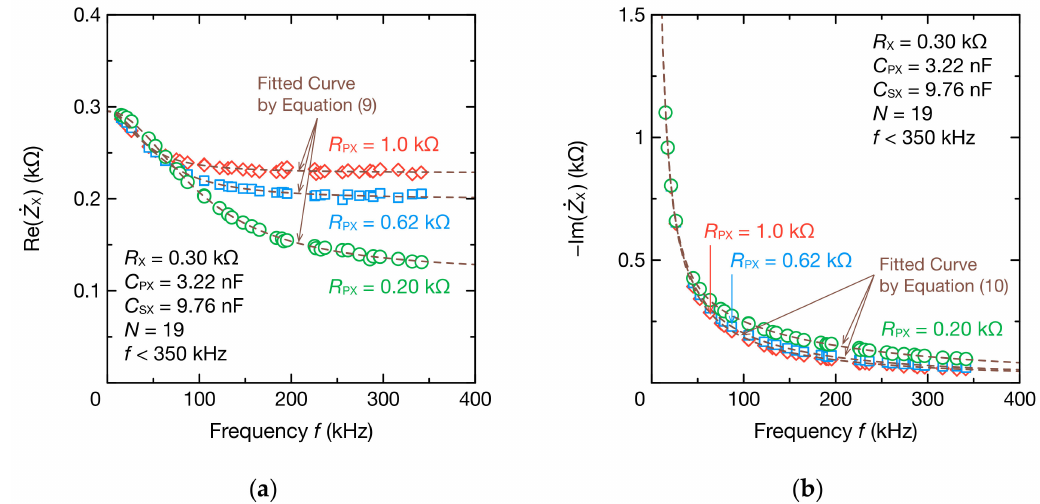
(cid:16) . (cid:17) Z X and ( b ) imaginary part Im